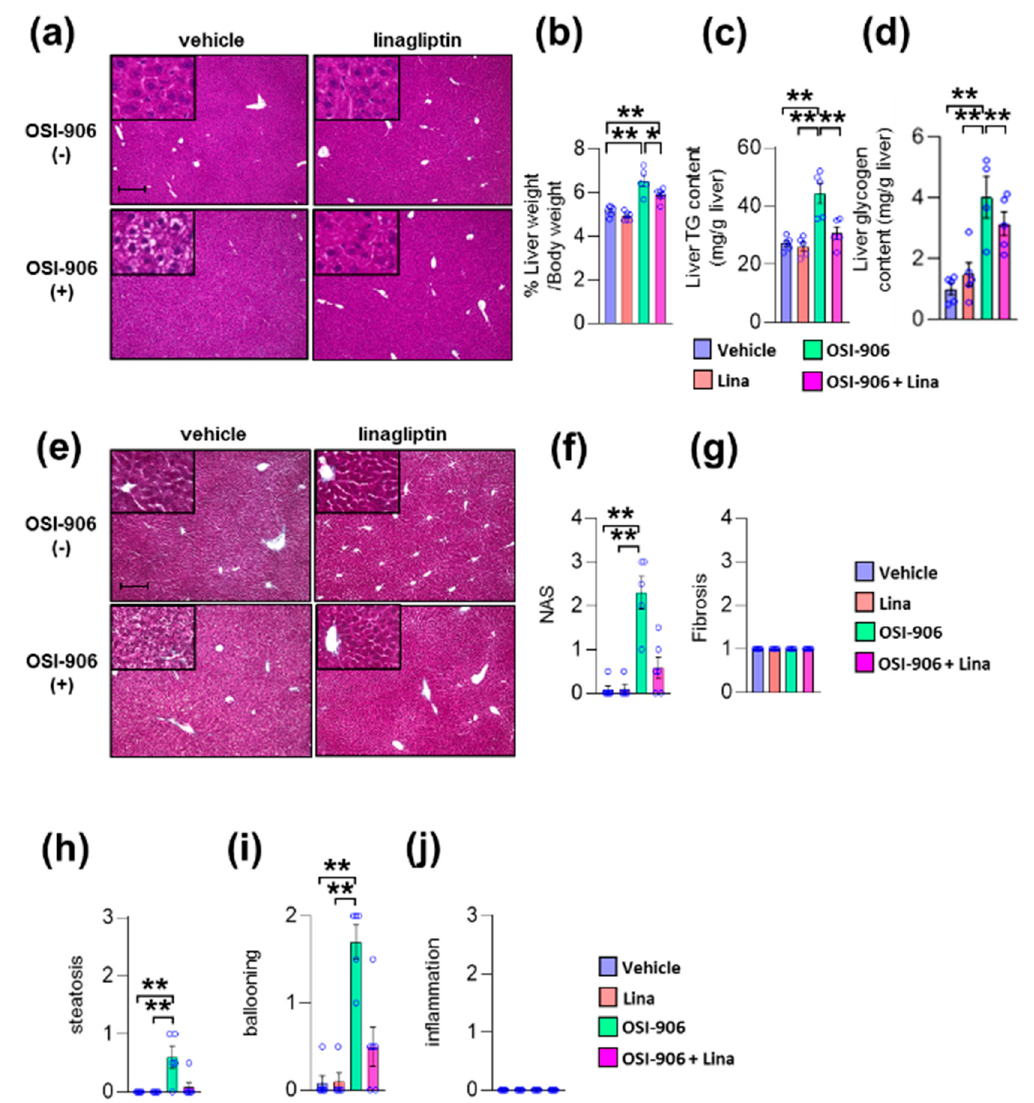
Figure 2. Linagliptin improved hepatic steatosis evoked by OSI-906. ( a ) Hematoxylin and eosin-stained sections of liver on day 7. Scale bar = 200 μ m. ( b ) Ratio of liver weight to body weight on day 7. ( c , d ) Triglyceride (TG) and glycogen content in the liver on day 7. Data represent the mean ± SEM. * p < 0.05, ** p < 0.01 ( n = 5 per group) by ANOVA with an additional Tukey–Kramer post-hoc test. ( e ) Masson–Goldner-stained section of liver on day 7. Scale bar = 200 μ m. ( f ) Non-alcoholic fatty liver disease (NAFLD) activity score (NAS), ( g ) fibrosis staging, and ( h ) the degree of steatosis, ( i ) hepatocyte ballooning, ( j ) lobular inflammation of liver sections according to the NAFLD activity score (NAS) score. Data represent the mean ± SEM. * p < 0.05, ** p < 0.01 ( n = 4–6 per group) by Kruskal–Wallis